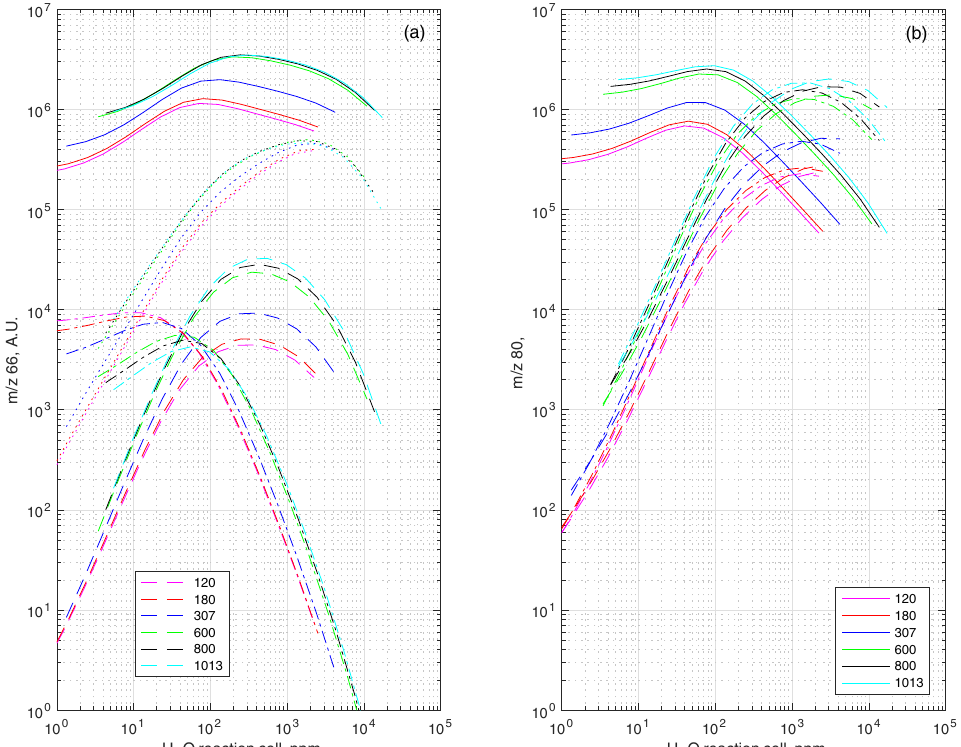
( H 2 O 2 ) solid lines, 18 O of NO − ( H 2 O ) dashed 2 2 ( CH 3 OOH ) solid lines, 18 O of CO − ( H 2 O ) dashed lines 2 3